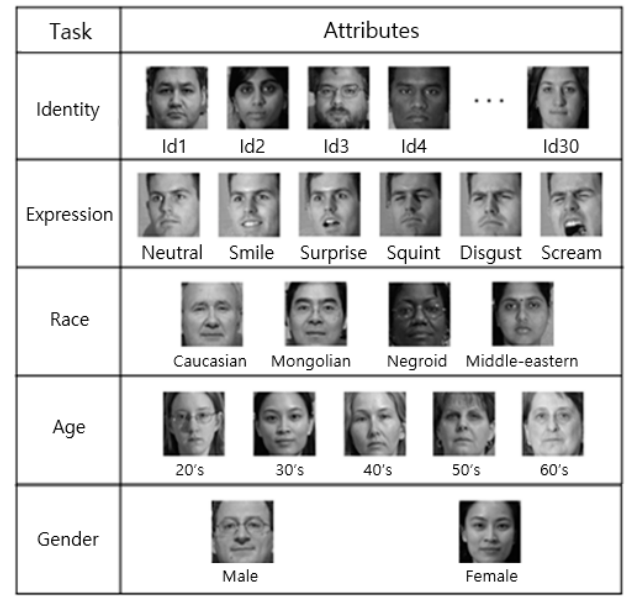
Figure 6. Examples of CMU Multi-PIE data.